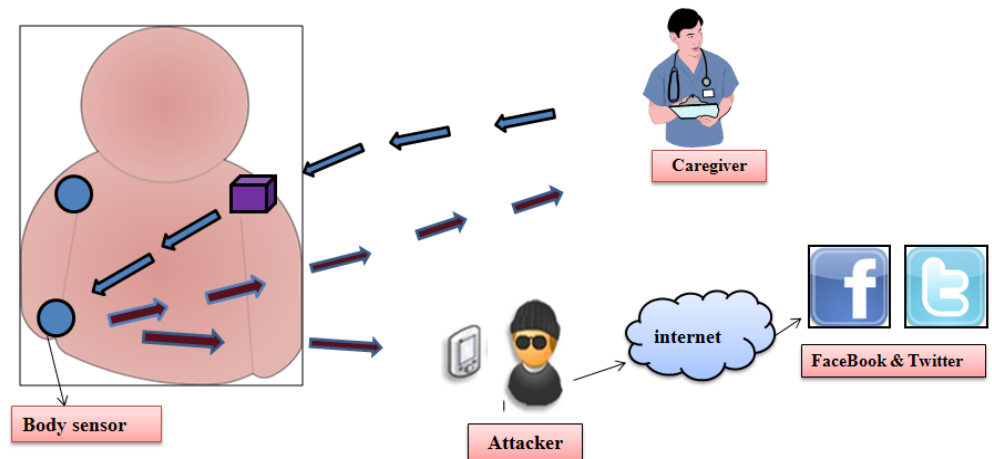
Figure 3. Risks to patient